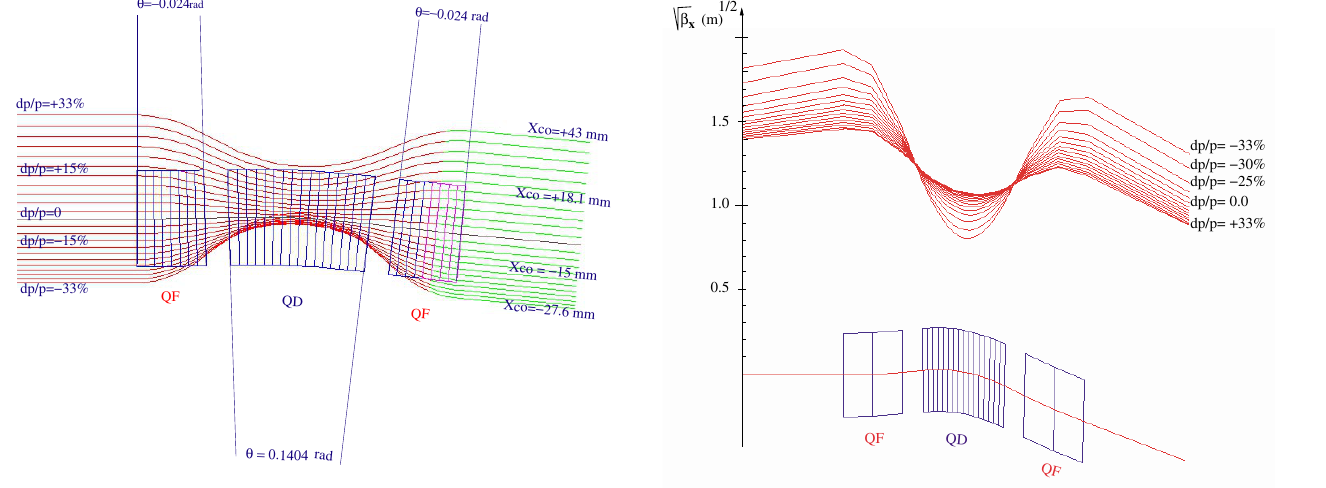
FIG. 15. (Color) Dependence on momentum of (cid:2)(cid:2)(cid:2)(cid:2)(cid:2)(cid:2) (cid:5) lated by the PTC code.